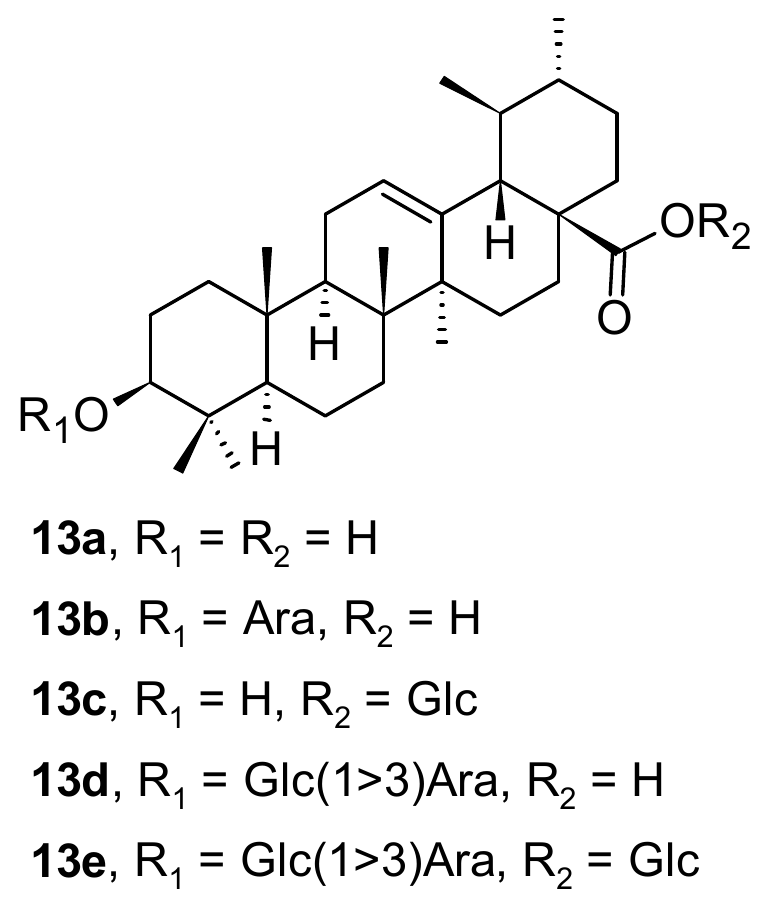
Figure 13. Ursane-type triterpenoids found in the leaves of Aralia dasyphylla. Table 2. The cell survival values and in vitro cytotoxicity of 13a – 13e in three different cancer cell lines [35].